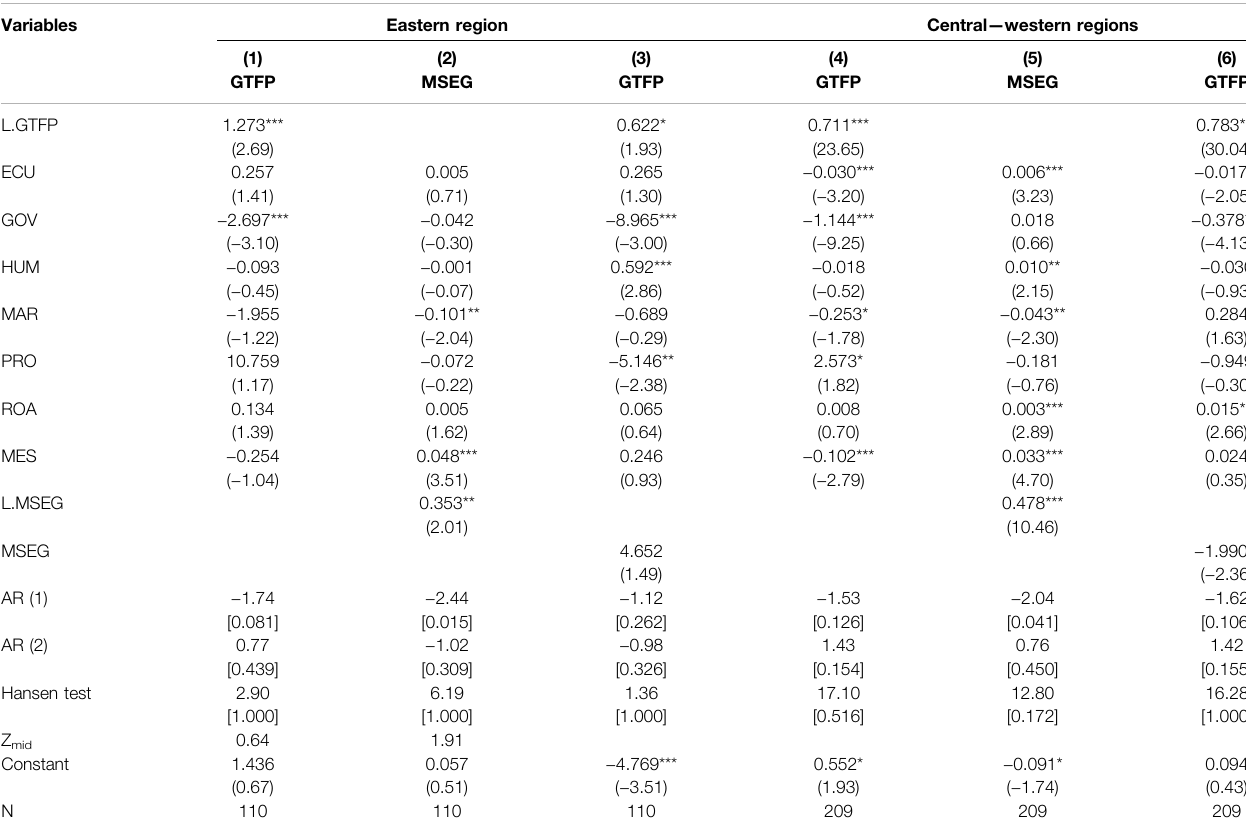
TABLE 7 | Regional